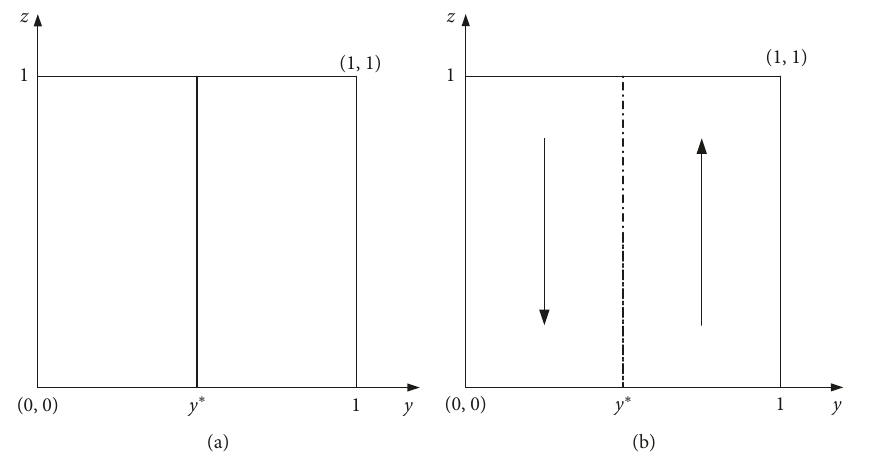
Figure 3: Replicator dynamic phase diagram of SMEs. (a) y